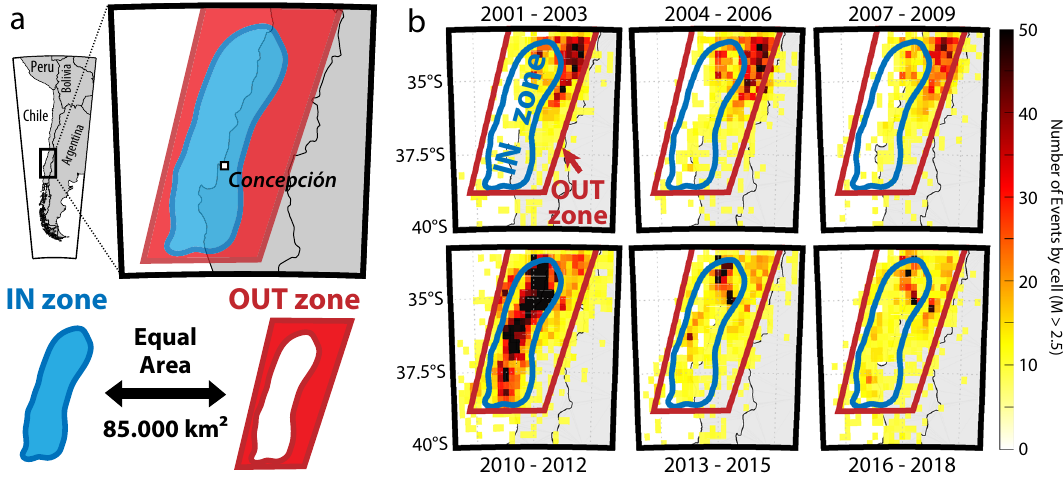
Figure 1. Studied area and associated seismic rate from 2000 to 2018. ( a ) Geometry of the studied zone. The Maule coseismic rupture area (IN-zone, blue patch, from Moreno et al . 36 ) and the surrounding zone (OUT-zone, red patch) are area-equivalent and together contain 95% of the entire recorded seismicity within the region defined in ( b ) for the considered period. ( b ) Seismic density maps by sets of 3 years segments from 2001 to 2018. All the events of the catalog used are